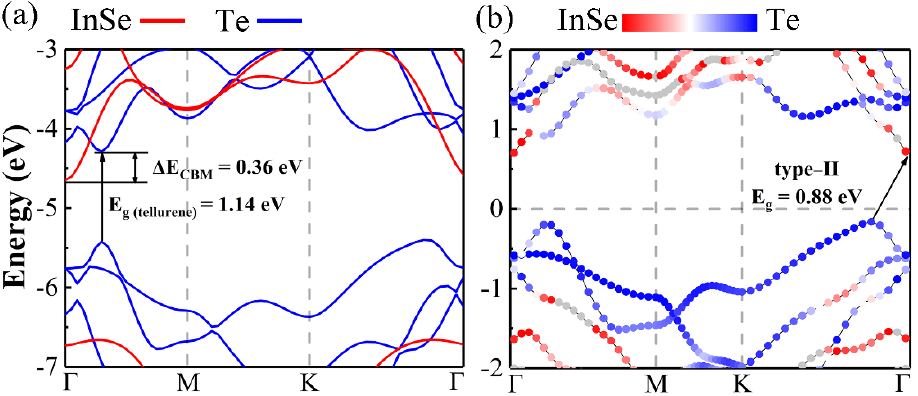
Figure 4. ( a ) Overlap band structures of mutually independent monolayers fixed in InSe/Te heterostructure and ( b ) projected band structure of InSe/Te heterostructure via HSE06 hybrid functional method.